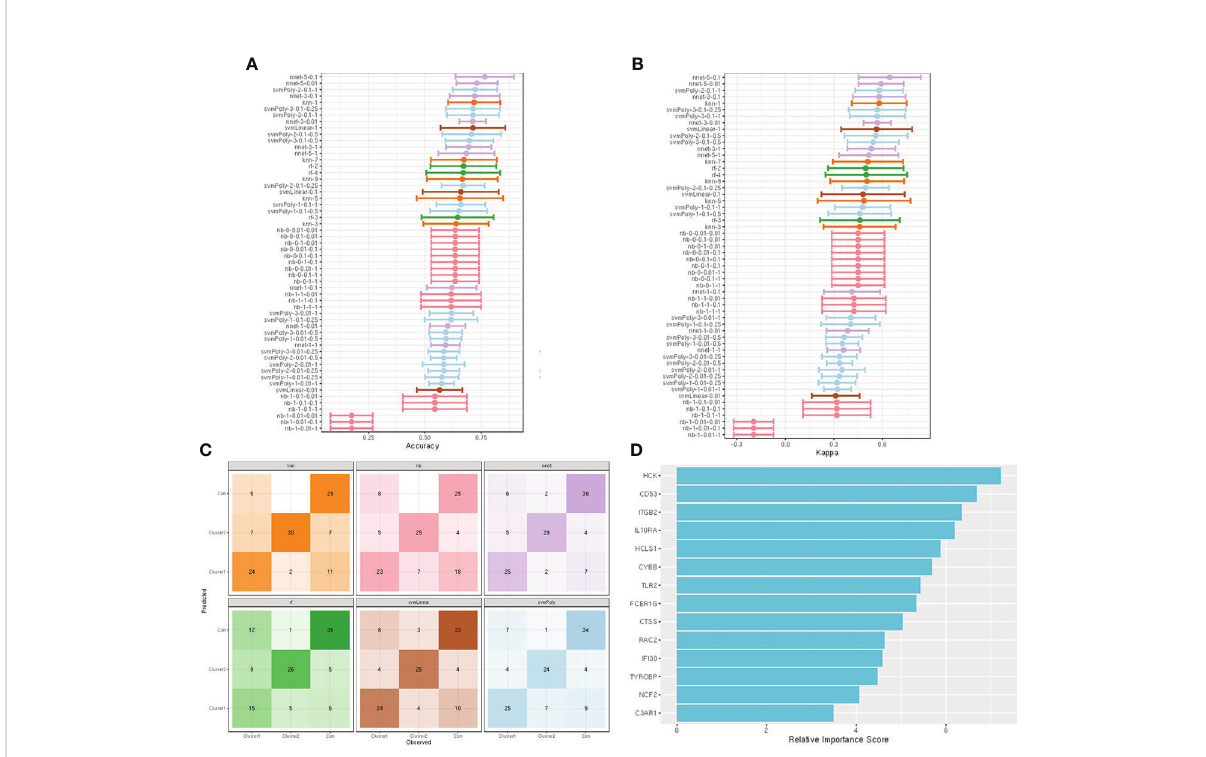
FIGURE 8 construction and evaluation of ML models. (A) The cross-validation results of the accuracy of all models. (B) The cross-validation results of the kappa-value of all models. (C) The observed vs . predicted (best candidate for algorithm) of all models. (D) Feature importance of genes in the ML models.